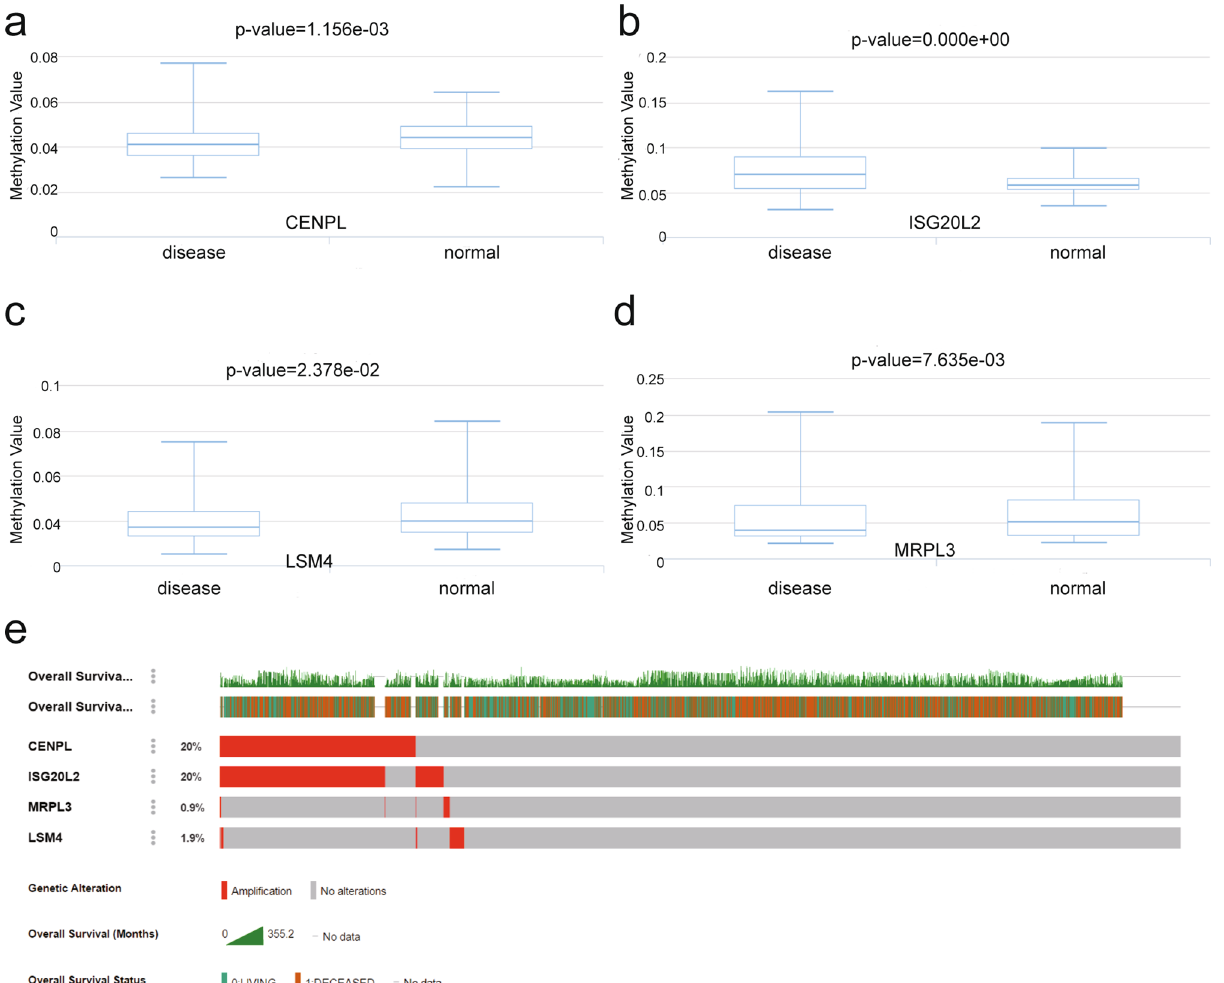
Figure 4. Methylation level analyses and genetic alteration of novel hub genes for breast cancer. ( a–d ) the methylation levels of CENPL, ISG20L2, LSM4, and MRPL3 in breast cancer and normal tissues were examined using DiseaseMeth 2.0 databaset based on 450 k (Illumina Infinium HumanMethylation450 BeadChip) platform; ( e ) Genetic alterations of CENPL, ISG20L2, MRPL3, and LSM4 were examined in cBioPortal